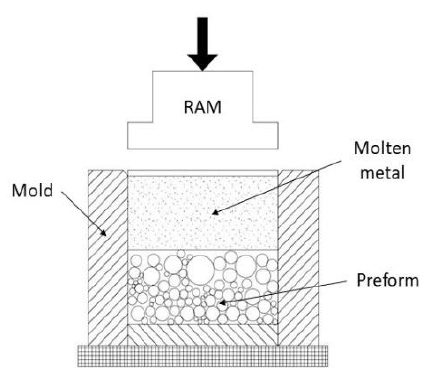
Figure 4. Schematic view of Downward Pressure Infiltration Mechanically Assisted Technique (DIM) set-up adapted from Brothers et al. [63].